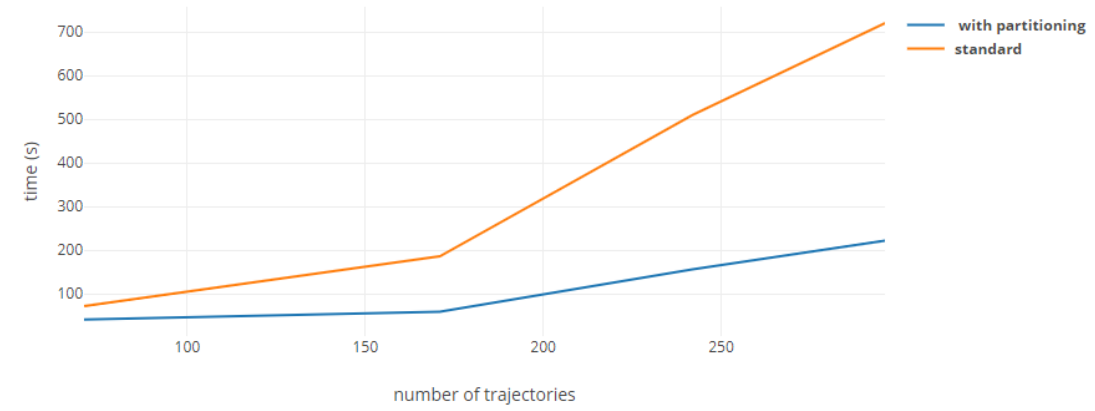
Figure 8. Execution time before and after integrating the LoadPartitioner